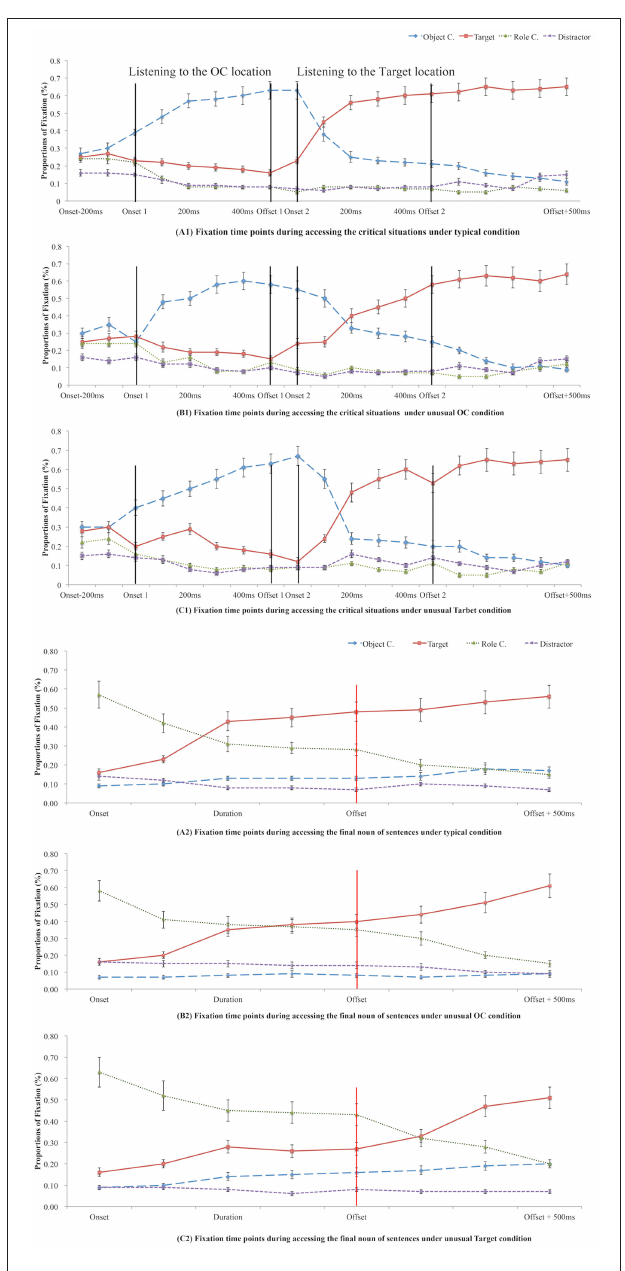
FIGURE 2 | Mean proportion of fixations while listening to the critical locations (OCs or Targets in A1, B1, and C1) or listening to the final noun of the sentence (retrieving Targets in A2, B2, and C2) in Experiment 1 under different conditions of appropriateness of word pairs’ coexistence (A, B, or C).